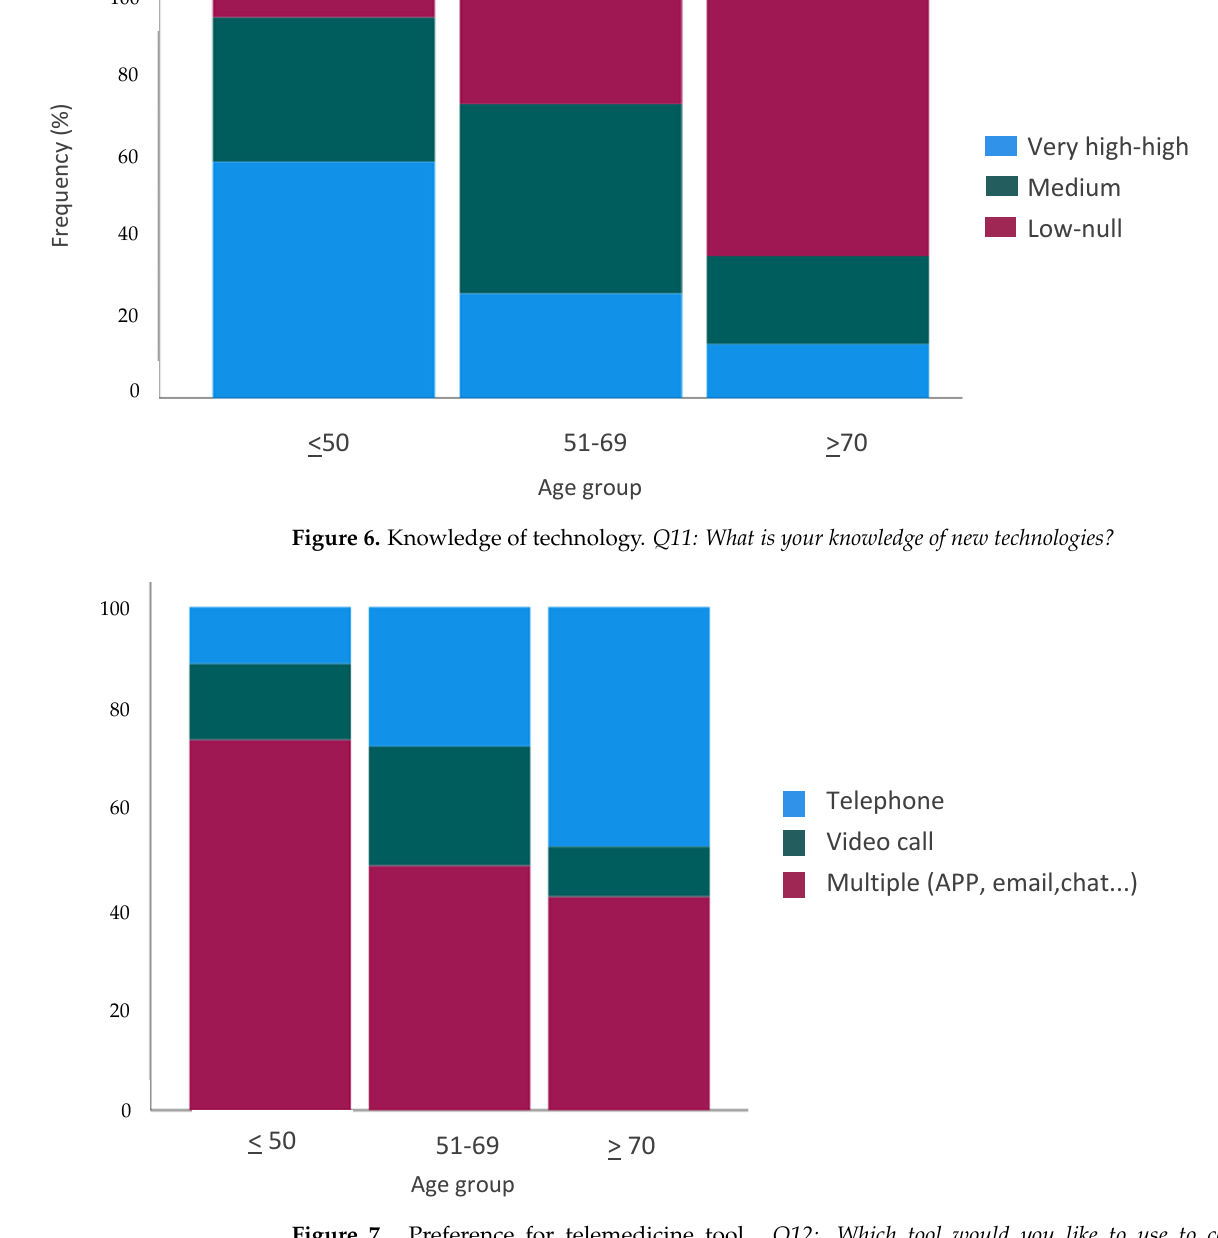
Figure 7. Preference for telemedicine tool. Q12: Which tool would you like to use to contact your oncolo- gist?